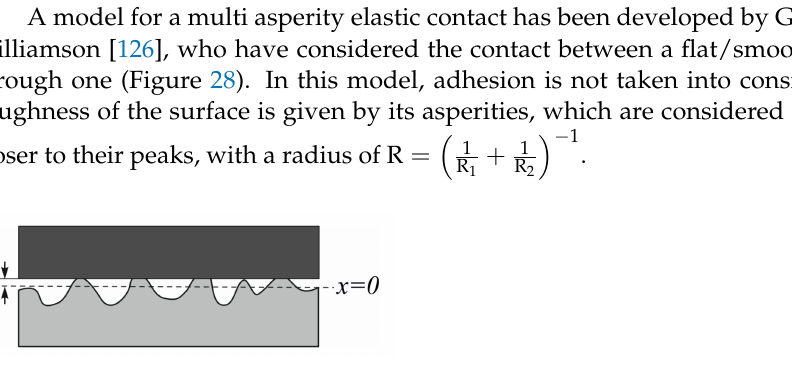
Figure 28. The separation d is defined as the level of the smooth plane with respect to the reference plane at x =